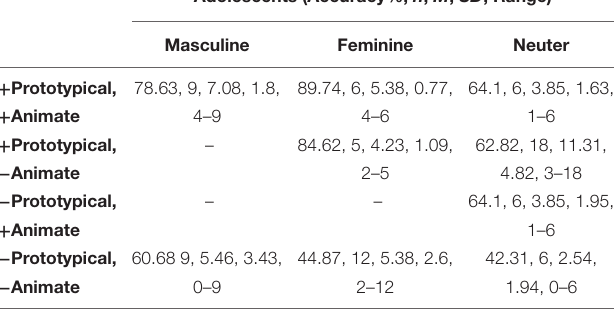
TABLE 8 | Accuracy, number of items, mean number, standard deviation, and range of correct responses per prototypicality condition in the older group (adolescents).